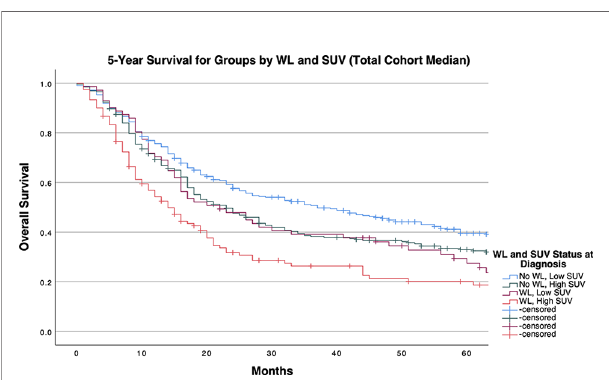
FIGURE 1 | 5-Year Overall Survival Strati fi ed by Signi fi cant Pretreatment Cancer-Associated Weight Loss (WL) and Primary Tumor SUV Max Group Determined by Survival-Optimized Cutpoint.